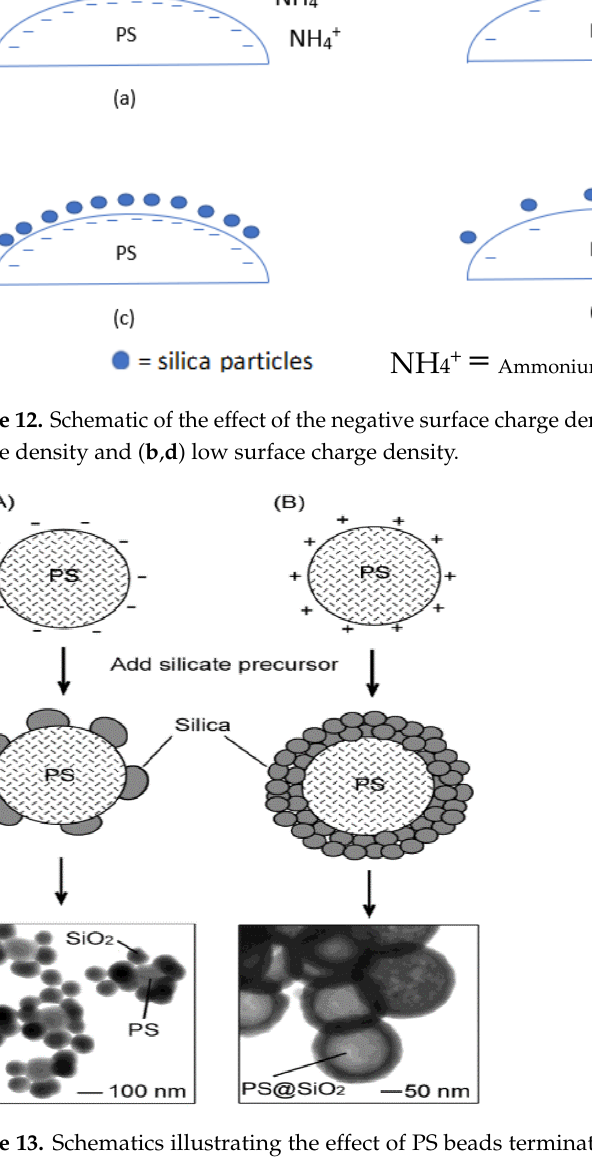
Figure 13. Schematics illustrating the effect of PS beads terminated in ( A ) the –SO 3 and ( B ) –NH 2 groups. The TEM images of the PS coatings obtained are also shown [98].